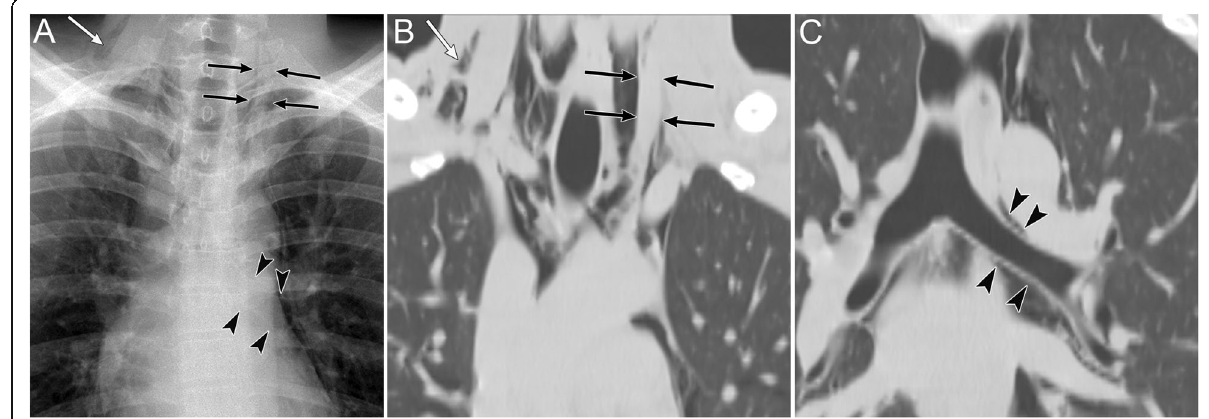
Fig. 13 Pneumomediastinum due to chronic cough and vomiting in a 22-year-old man. a A supine radiograph shows the “ tubular artery ” sign (black arrows) and the “ double bronchial wall ” sign (black arrowheads). Subcutaneous emphysema is also evident (white arrow). b A coronal cervical CT image shows the “ tubular artery ” sign (black arrows). Both sides of the left internal jugular vein are visible due to pneumomediastinum. Subcutaneous emphysema is also visible (white arrow). c The coronal CT image at the carina level shows the “ double bronchial wall ” sign (black arrowheads). Both sides of the left bronchial wall are visible because of air in the bronchus and pneumomediastinum surrounding the